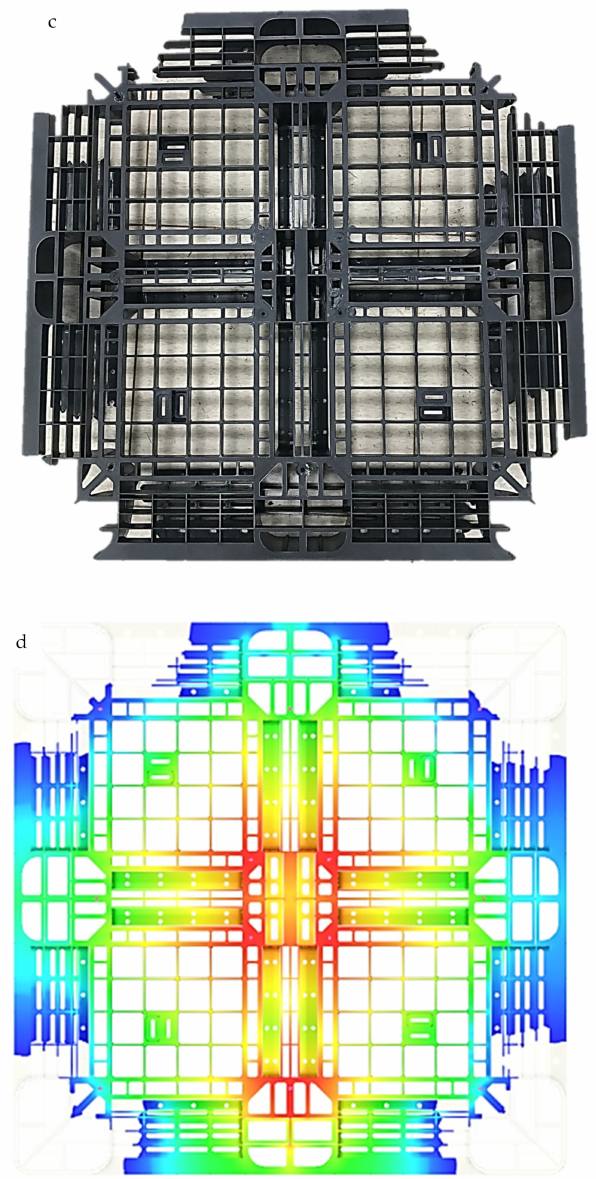
Figure 3. Comparisons of the experimental and numerical flow fronts in short-shot testing under the preset sequential valve gate scheme: ( a ) 57.9% short-shot true pallet; ( b ) 57.9% numerical flow front of short-shot testing; ( c ) 74.4% short-shot true pallet; ( d ) 74.4% numerical flow front of short-shot